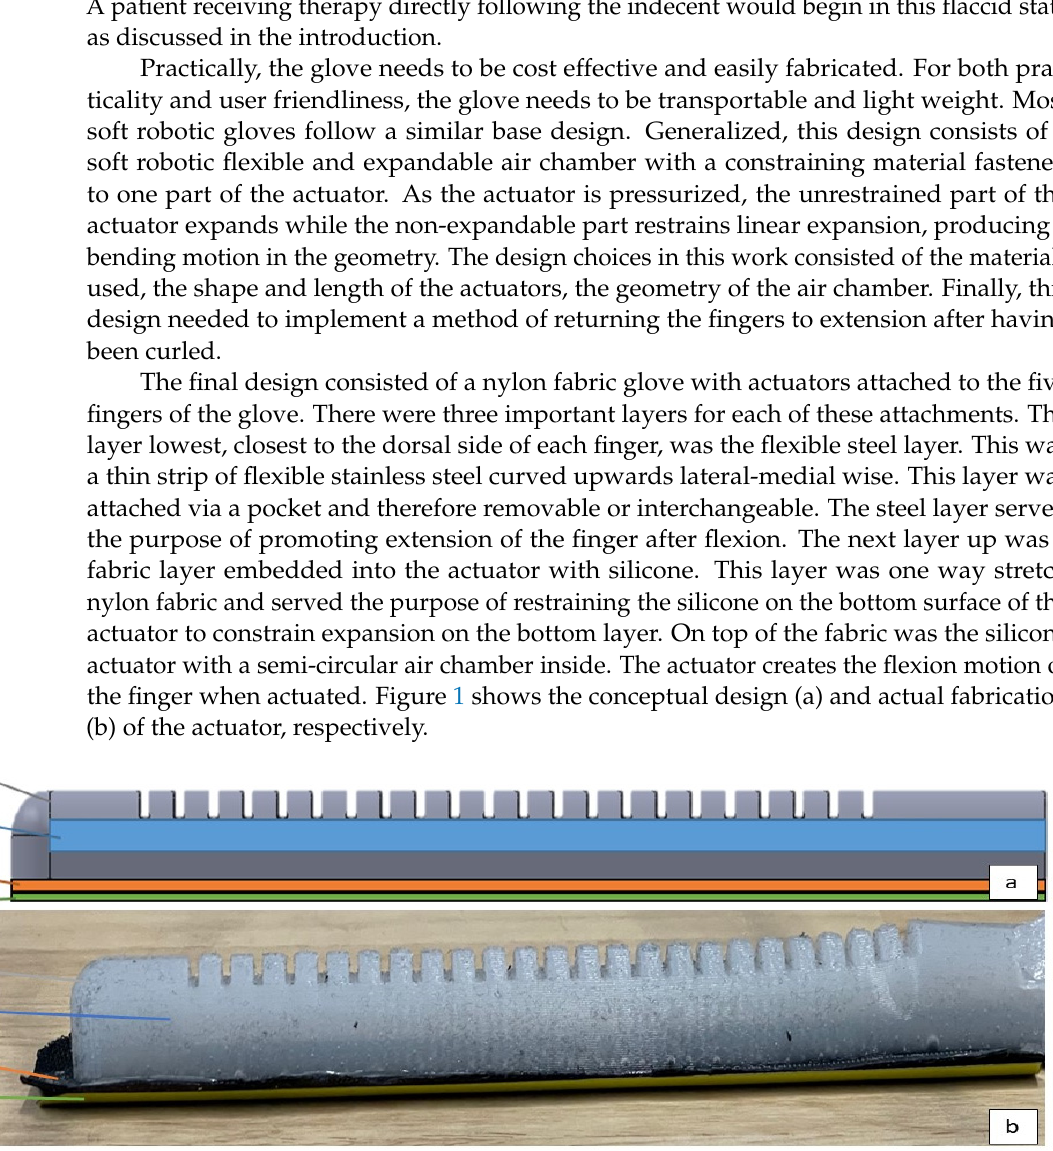
Figure 1. Diagram showing the make-up of the layers of the soft robotic actuator finger design ( a ) and actual fabrication ( b ). actual fabrication ( b